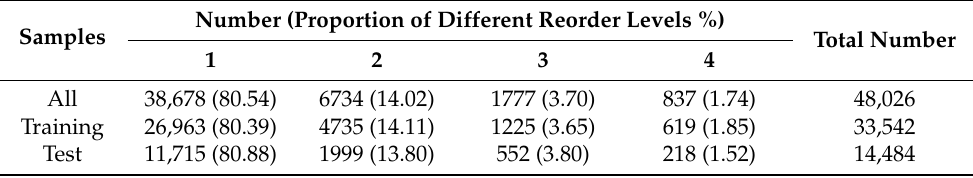
Table 2. Samples and their proportion of different reorder